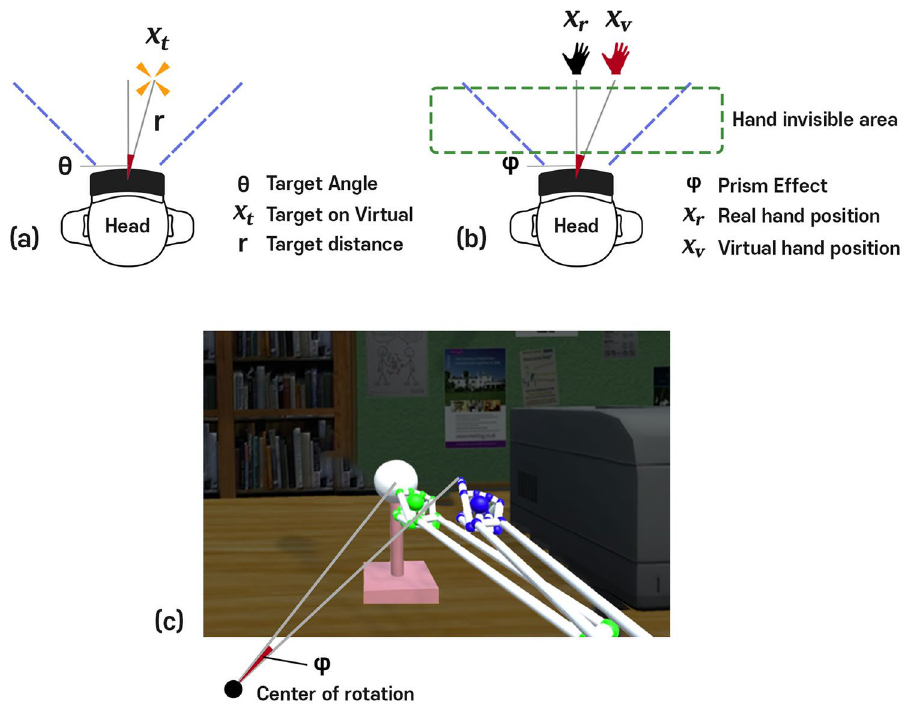
Figure 3. Hand trajectory deviations in VPAT system. ( a ) Target location ( x t ) defined as angle ( θ ) and distance ( r ) from initial calibration, ( b ) Virtual hand position ( x v ) shifted to the right side at a deviation angle( ϕ ) from the real hand position ( x r ) , ( c ) Hand trajectory: The green hand indicates the real hand trajectory and the blue hand indicates the virtual hand trajectory shifted to the right